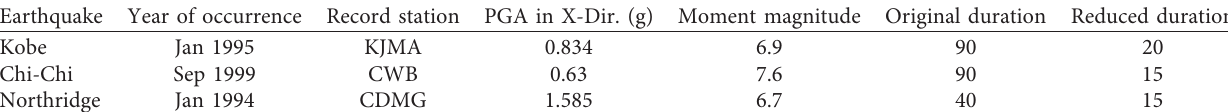
Table 4: Seismic ground motions.